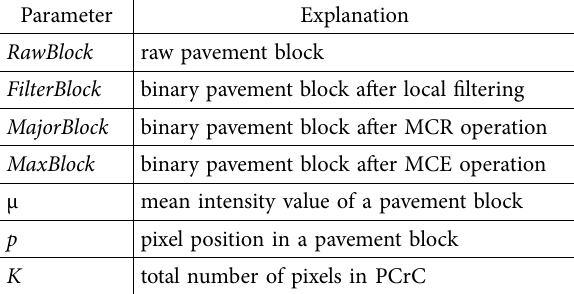
Table 2. Explanation of notations